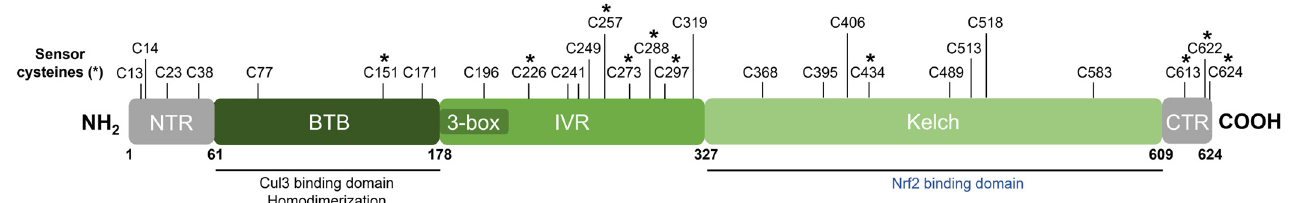
Figure 5. Domain structure of human Keap1. Keap1 contains three functional domains and a 3-box motif within the proximal part of the IVR domain. The location of all cysteine (C) residues in Keap1 is shown, and key stress-sensing cysteines are marked with an asterisk